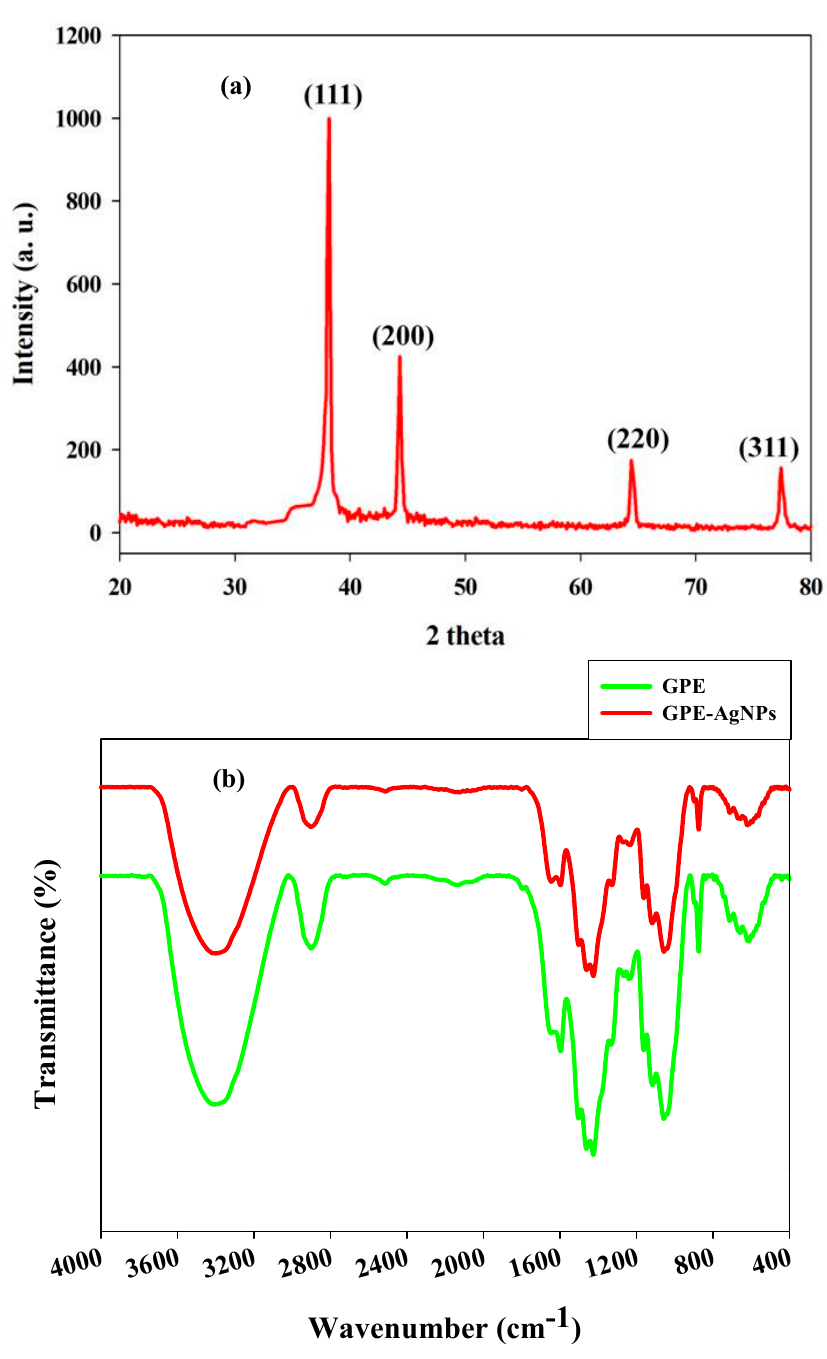
Figure 2. ( a ) X-ray di ff raction pattern of synthesized GPE-AgNPs and ( b ) FTIR spectrum of GPE and synthesized